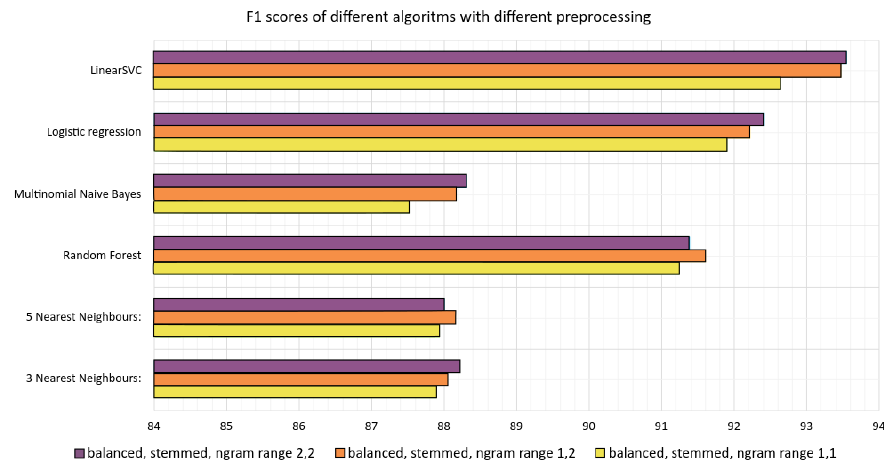
Figure 3. Performance of different classifiers on “Termination of employment” subject matter from labor law area, and effect of n-gram